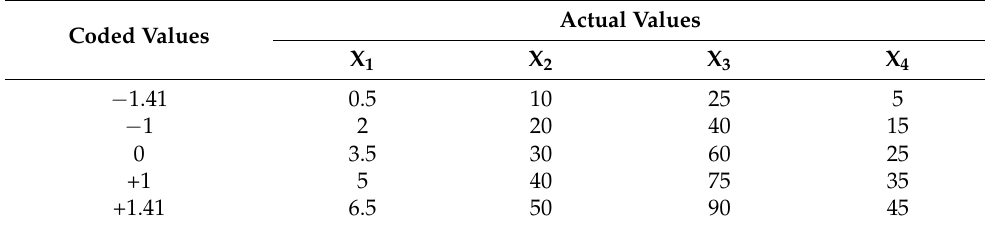
Table 4. Actual and coded values of independent